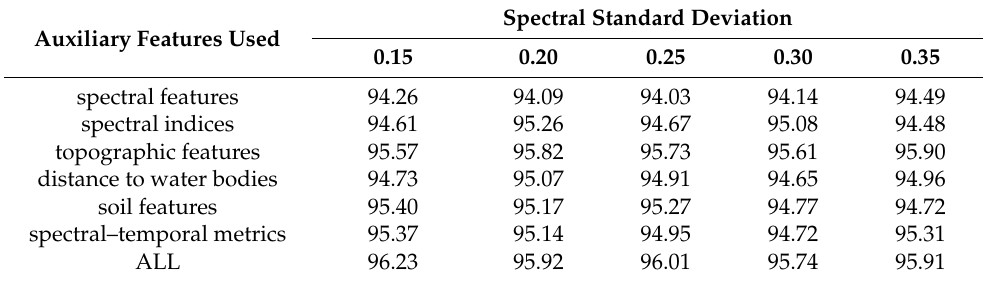
Table 6. The object-based classification overall accuracies by different spectral standard